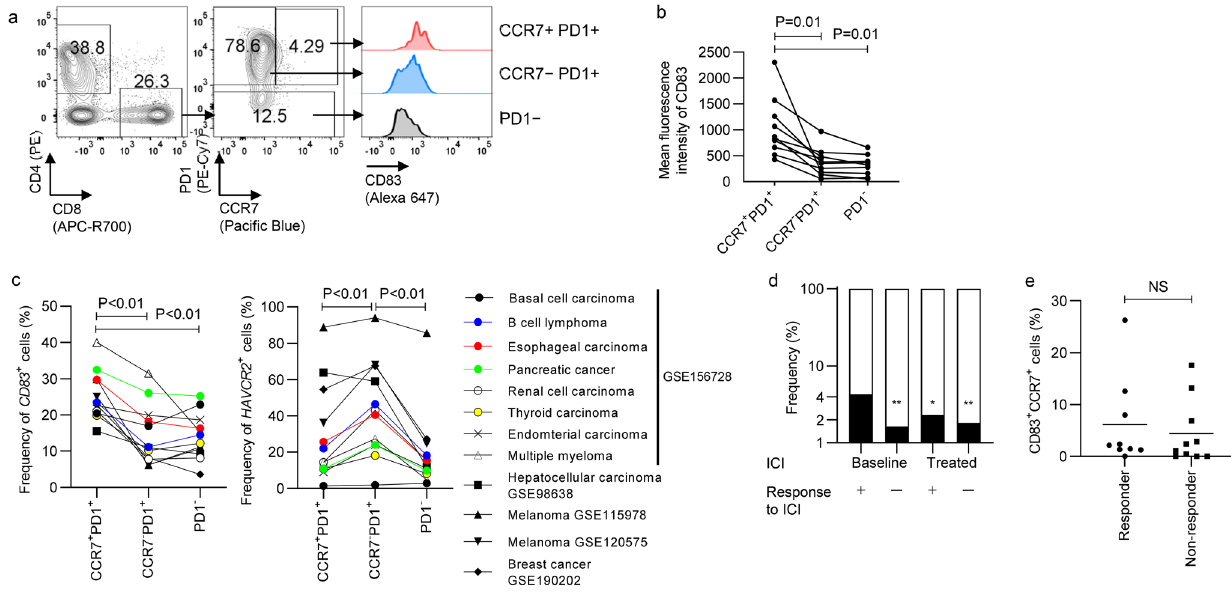
Fig. 7 CD83 is expression is skewed in the CCR7 + PD1 + T-cell population within the tumor tissue. a , b CD83 expression was analyzed in TIL samples from patients with gynecologic malignancies. The data shown are representative fl ow cytometry plots ( a ) and the mean fl uorescence intensity of CD83 in the CD8 + T-cell populations ( b ), ( n = 10 different samples, repeated measures one-way ANOVA with multiple comparison test). c Single-cell RNA- sequencing data of TIL from various cancer types were analyzed for the proportion of CD83 + cells within the CCR7 + PD1 + , CCR7 - PD1 + , and PD1 − CD8 + T cell populations ( n = 12 datasets, repeated measures one-way ANOVA with multiple comparison test). d In the GSE120575 data, the proportion of CD83 + CCR7 + cells within the total CD8 + T cells were compared among the samples collected before or after treatment with immune checkpoint inhibitors in the responder or non-responder patients ( n = 1005, 1587, 1082, and 3067 cells, * P < 0.05, ** P < 0.01, Fisher ’ s exact test with multiple testing correction). e The frequency of CD83 + CCR7 + cells was calculated in the individual patients ’ samples with or without response to immune checkpoint inhibitors using the GSE120575 dataset ( n = 9 or 10 patients, unpaired two-tailed t -test; NS not signi fi